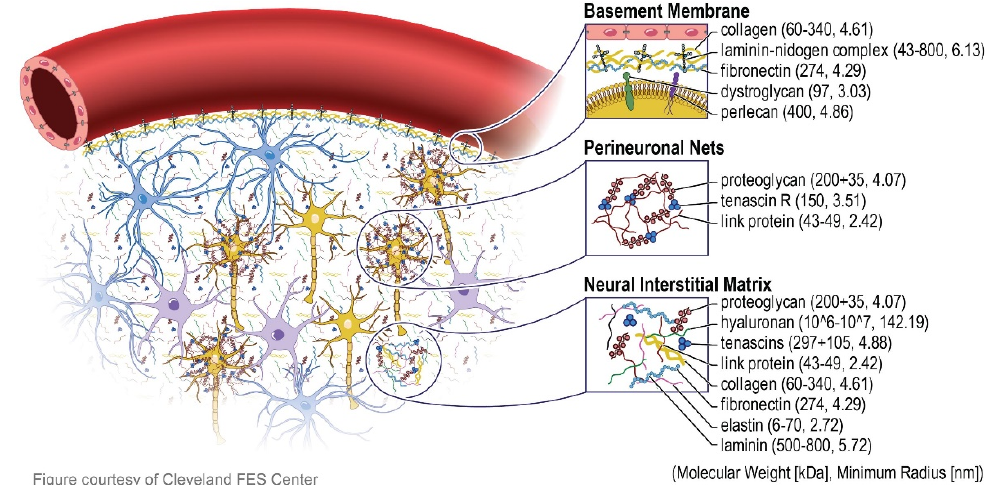
Figure 1. The composition of major compartments of brain ECM. The ECM in the brain is composed of three primary components, namely the basement membrane (basal lamina) that surrounds the cerebral vasculature, the perineuronal net which lies around neuronal cell bodies and dendrites, and the neural interstitial matrix that is diffusely spread between parenchymal cells. The yellow, purple, and blue cells represent neurons, microglia, and astrocytes, respectively. All of the proteins that make up the ECM have a diameter of tens to hundreds of nanometers, providing inspiration for the next generation of nano-architecture-style cerebral electrodes. Figure adapted with permission from Ref. [24]. 2018, Kim U.